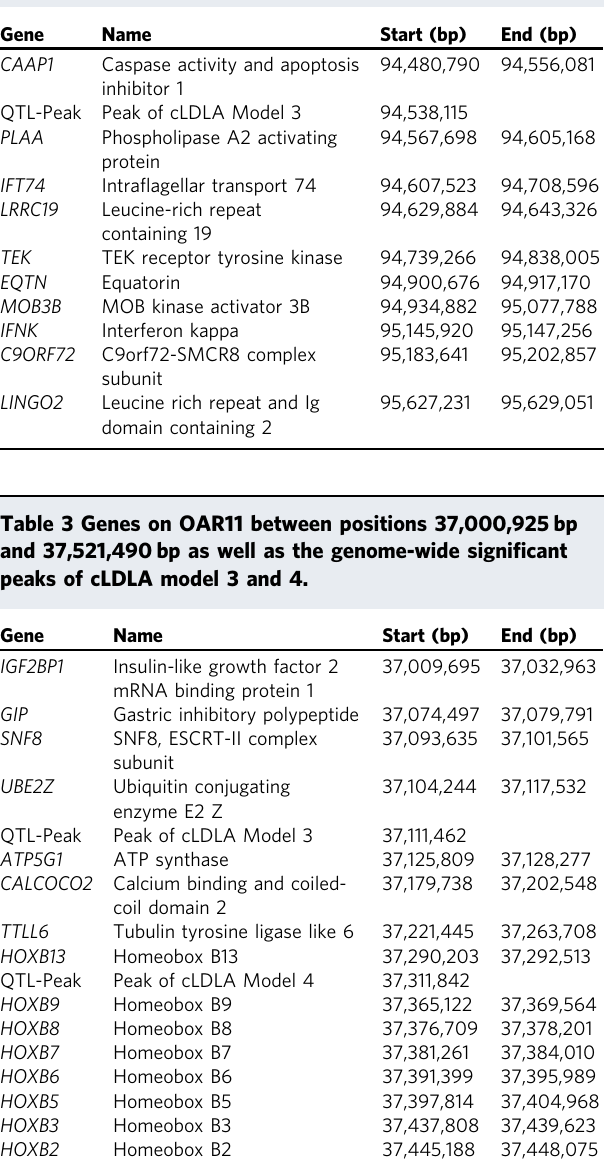
Table 2 Genes on OAR2 between positions 93,441,900 bp and 96,402,884 bp as well as the genome-wide signi fi cant peak of cLDLA Model 3.